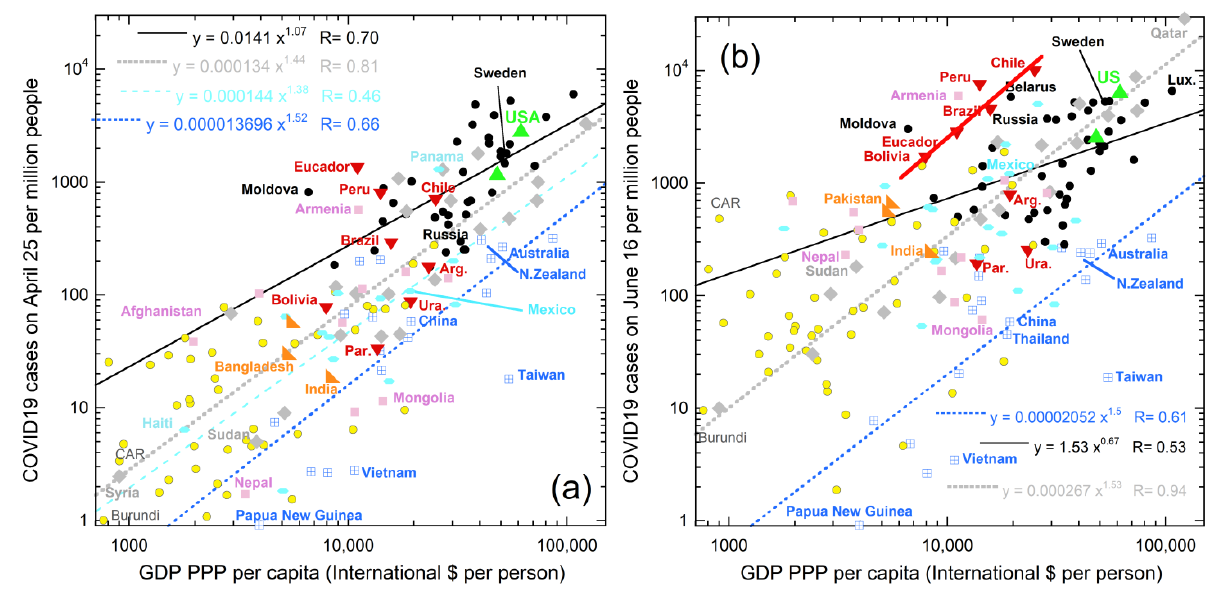
Figure 6. Log–log plot of incidence for proximal countries vs. wealth. See Figure 5 for data sources and text for groupings of countries: ( a ) COVID-19 on 25 April 2020; ( b ) COVID-19 from June 16th. Data from [46,53]. Changing categories of a few countries little affects the fits: examples are transferring Russia from the Europe grouping (black dots) to Central Asia (pink squares); or Mongolia to Southeast Asia/Oceania group (blue crossed squares); or Sudan from the Middle East (grey diamonds) to Africa (yellow dots with rims). Other symbols are: Red down-pointing triangles = South America countries which lie mostly in the SH. Turquoise oval = Mexico, Central American, and the Caribbean. Green up-pointing triangles = USA and Canada. Orange right triangles = populous India, Bangladesh, and Pakistan. The best constrained fits are shown.